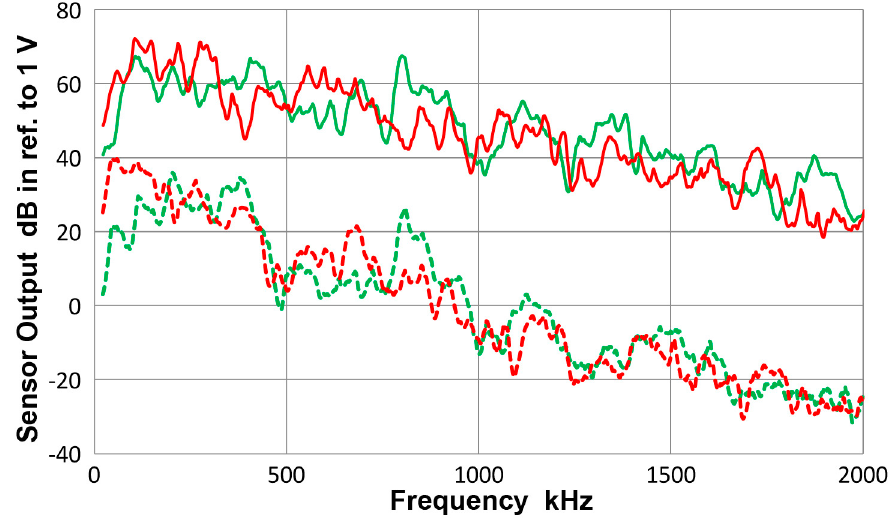
Figure 21. Frequency spectra of the four waveforms in Figure 20. Green curves for the sum and red for the difference. Solid curves are for FC500 transmitter and dashed ones for SH225 transmitter, which were shifted down 50 dB for better visibility.